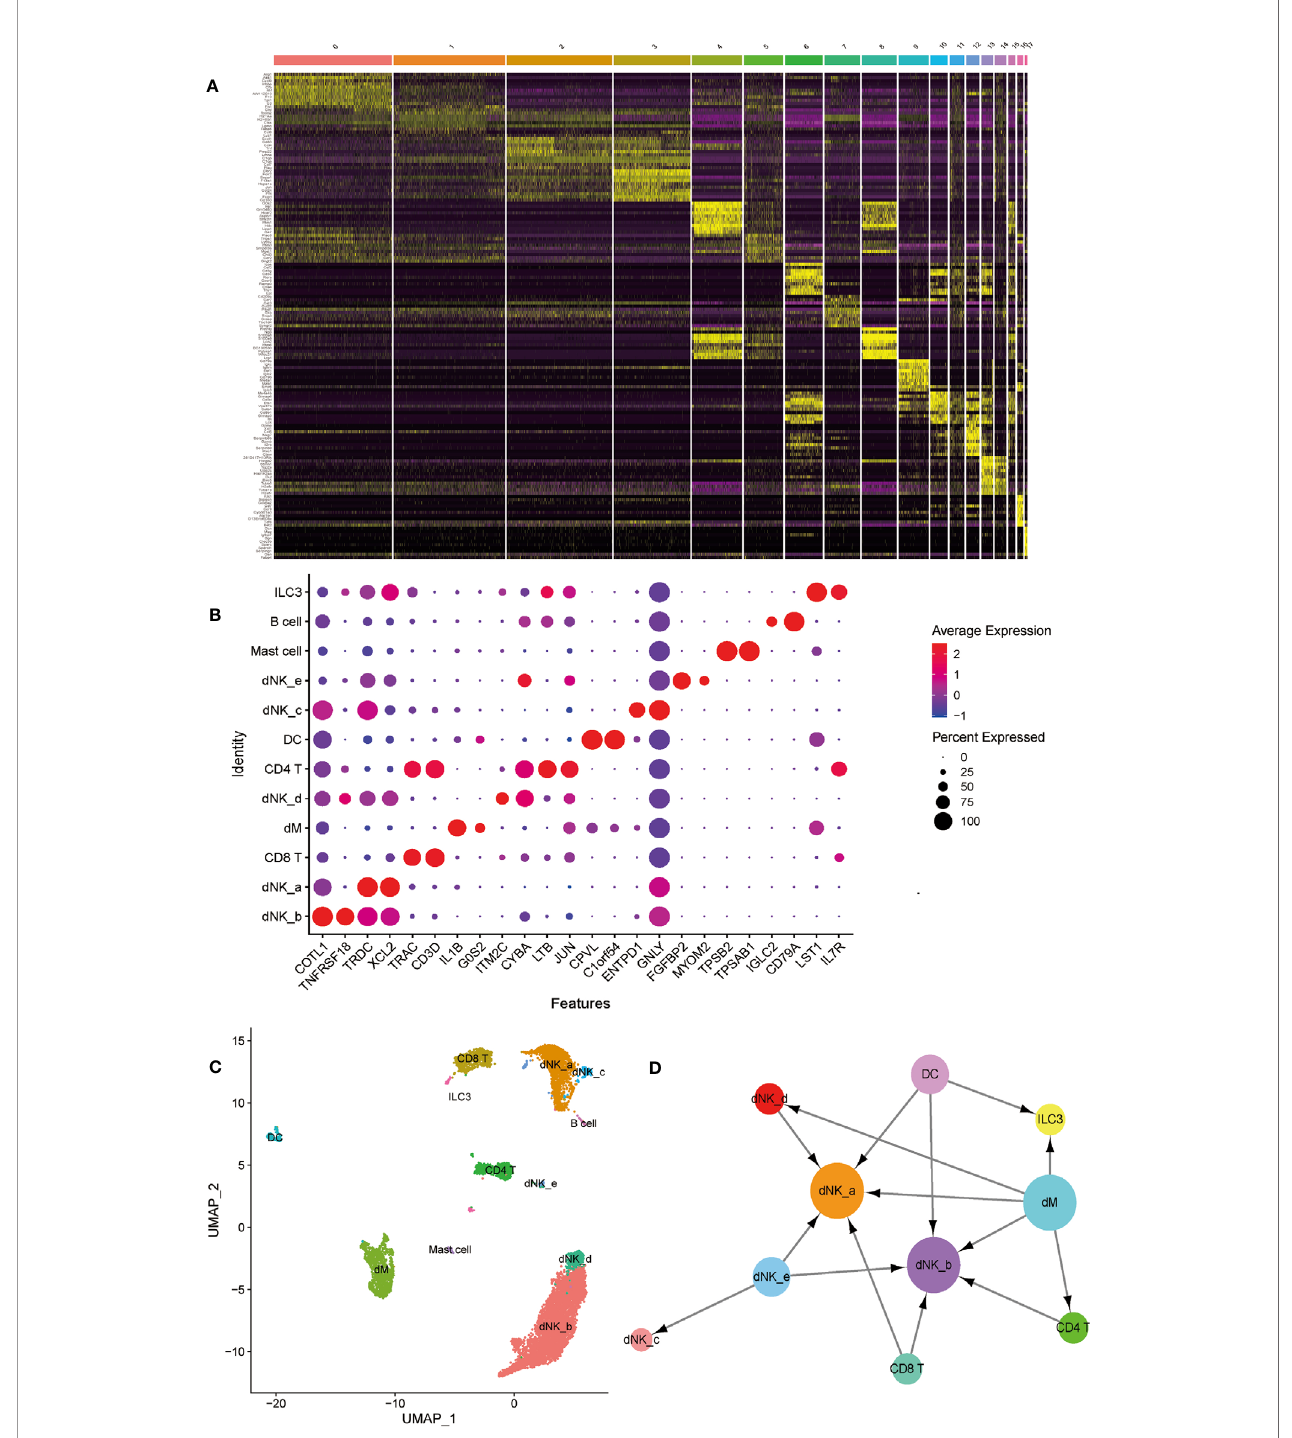
FIGURE 7 | The identi fi cation and interactions of decidual cell clusters by single-cell sequencing. (A) The heatmap showing the expression of differential genesin separate cell clusters of normal deciduas. (B) The dot plot reveals the expression of some known markers in each immune cell clusters of normal deciduas. The size of the ball represents percent expressed. The color of the ball represents average expression. (C) The UMAP visualization maps of various immune cell clusters in the normal deciduas by single cell RNA sequencing analysis. The various colors represent different types of cells. (D) The cell-to-cell interaction analysis was conducted by CellPhoneDB. Cell types are presented by nodes and interactions are indicated by arrows. The size of the nodes represents the number of cells contained in each cell type in the deciduas (p-value < 0.01). ! , export function; ← , import function. dM, decidual macrophages; dNK, decidual natural killer cells; ILC, innate lymphoid cells; DC, dendritic